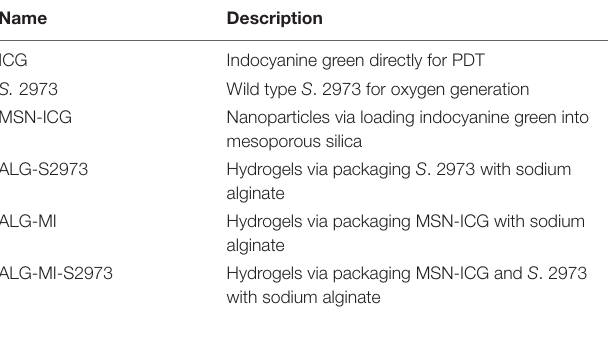
TABLE 1 | Detailed characteristics of the biomaterials used in this